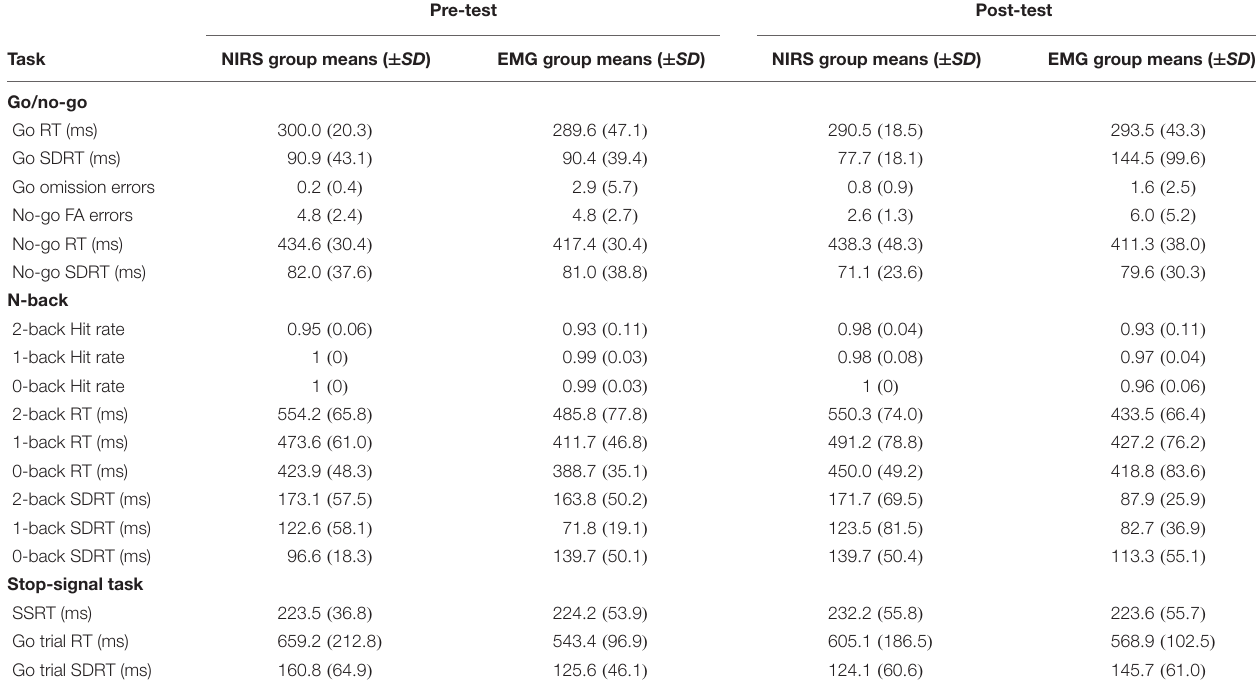
TABLE 1 | Behavioral data from pre- and post - test in the two experimental groups. Pre-test